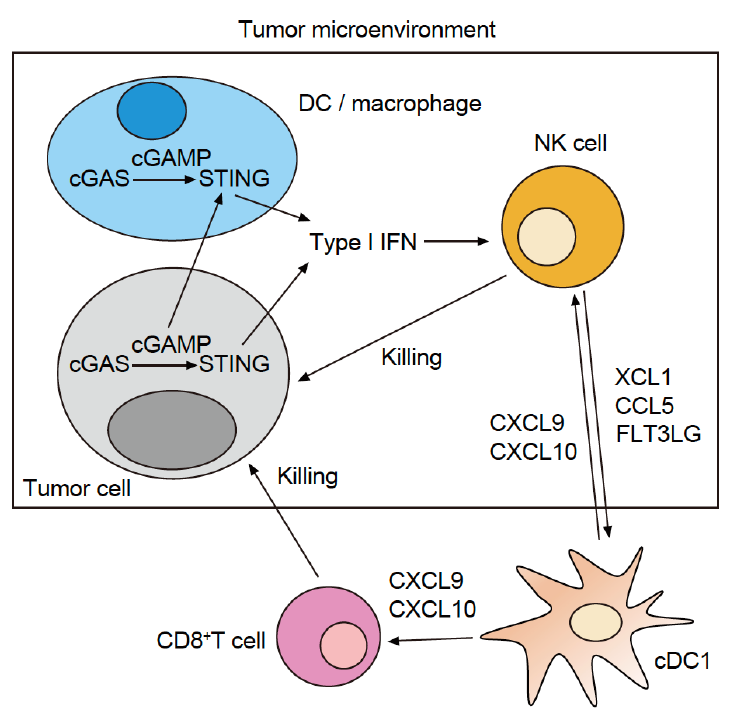
Figure 2. Role of type I IFN signaling and interaction between innate and acquired immunity. Type I IFN is produced by DC as well as macrophages in the tumor microenvironment and through the signaling mediated by CDSs within tumor cells. Additionally, type I IFN promotes the intratumoral infiltration of NK cells, which in turn promotes the intratumoral infiltration of cDC1 via XCL1, CCL5, and FMS-like tyrosine kinase 3 ligand (FLT3LG). Furthermore, cDC1 TIDCs induce CXCL9 and CXCL10 secretion in the tumor microenvironment, which in turn promotes the intratumoral infiltration of CD8+ T and NK cells.